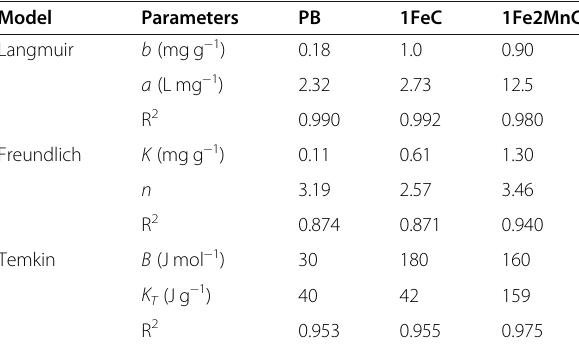
Table 4 Parameters for different isotherm of As (III) adsorption with biochars Model